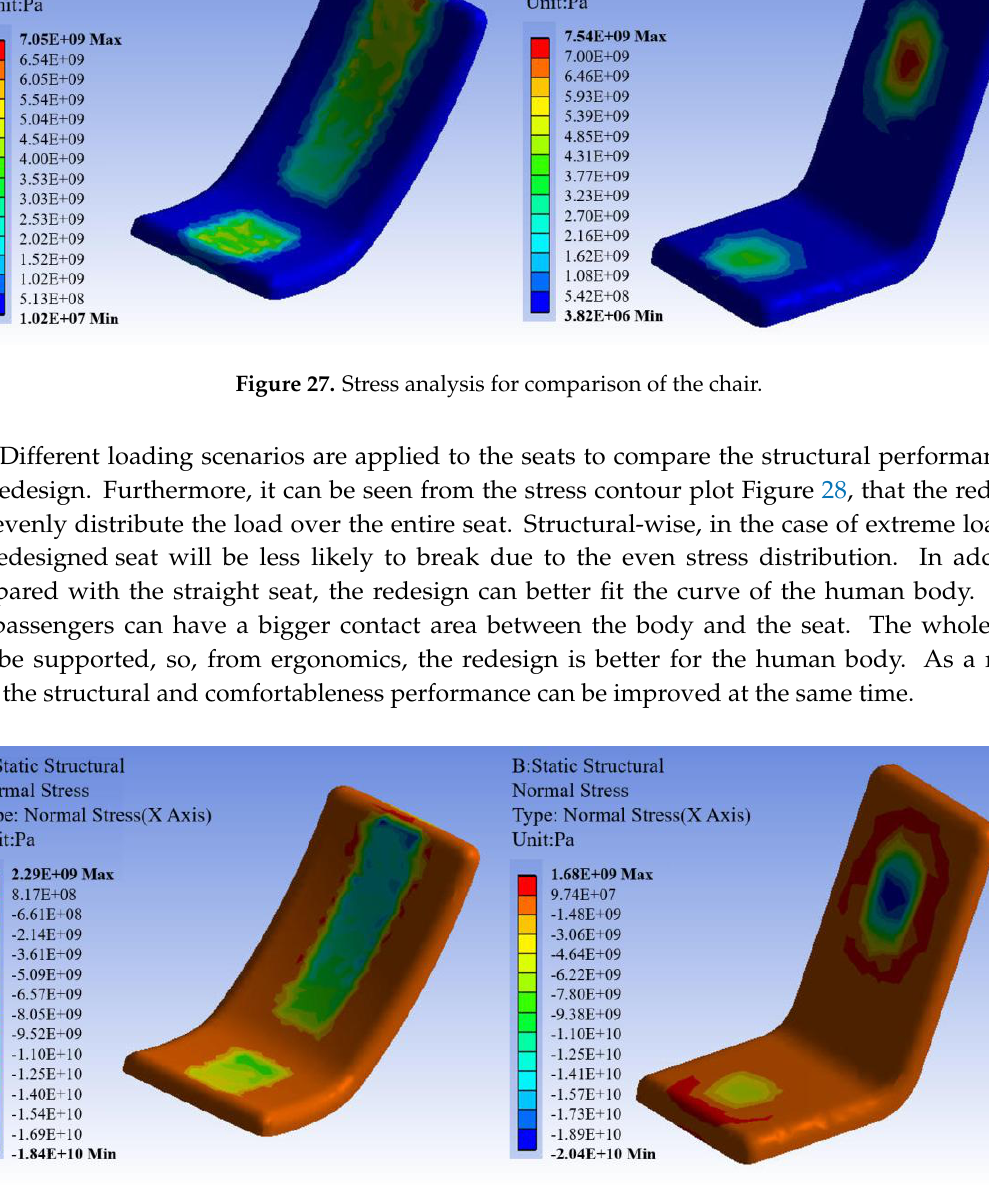
Figure 28. Stress analysis for comparison of the chair.